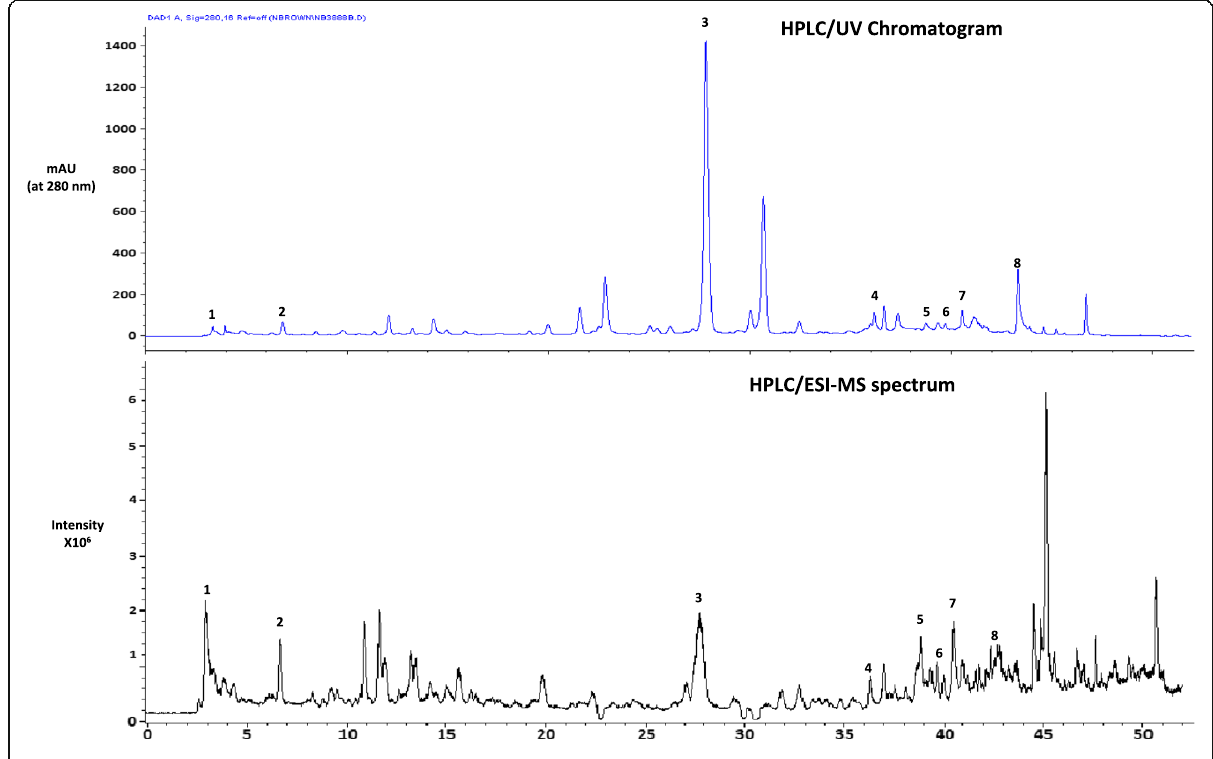
Fig. 4 HPLC/DAD chromatogram and HPLC/ESI-MS spectrum of the soluble phenolic components in non-dechlorophyllized Medina mint. Peak identities are numbered in Table